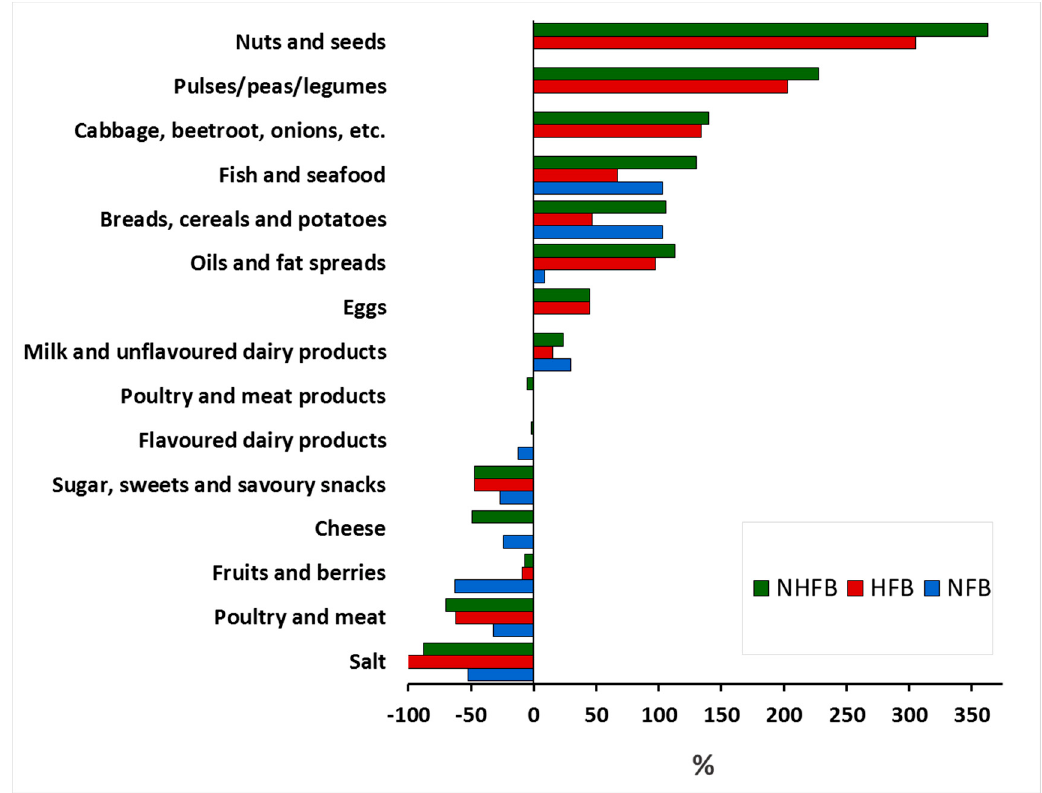
Figure 1. The relative differences between the contents of nutritionally adequate food basket (NFB, blue columns), health promoting food basket (HFB, red columns) and the nutritionally adequate and health promoting food basket (NHFB, green columns) and the Estonian National Dietary Survey (ENDS). The costs of the food baskets include the cost of alcoholic beverages.